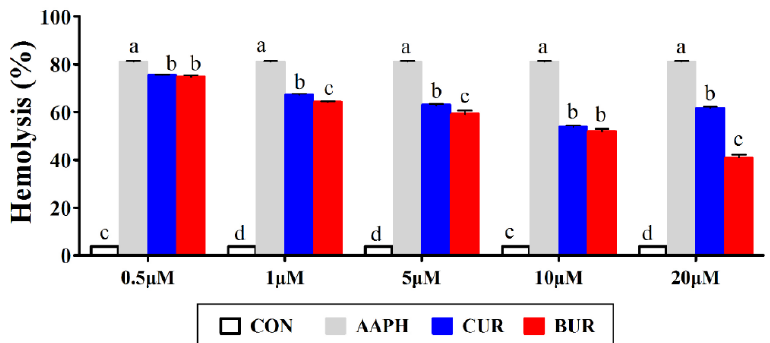
Figure 1. Effects of curcumin and bisdemethoxycurcumin on the hemolysis in 2,20-azobis(2- amidinopropane) dihydrochloride (AAPH)-treated erythrocytes (Experiment 1). Results are expressed as the mean ± SEM. Columns labeled with different letters are significantly different ( p < 0.05). CON group, the normal chicken erythrocytes; AAPH group, the chicken erythrocytes incubated with AAPH; CUR, the chicken erythrocytes pre-incubated with curcumin and followed by AAPH treatment; BUR group, the chicken erythrocytes pre-incubated with bisdemethoxycurcumin and followed by AAPH treatment.